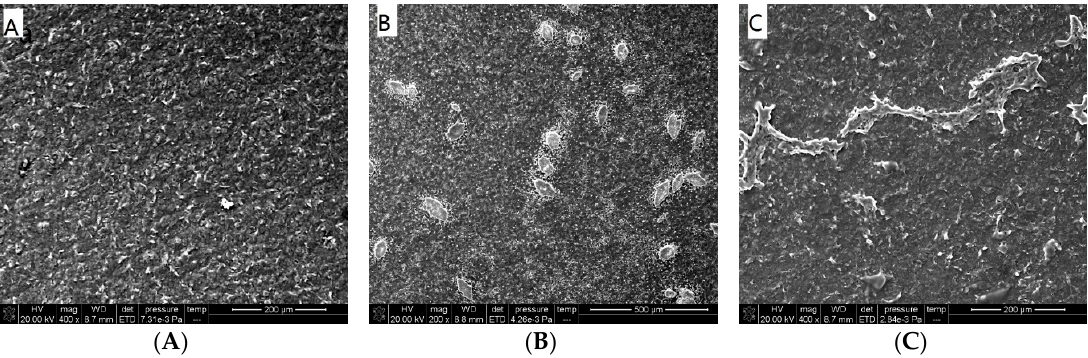
Figure 2. SEM images of different materials modified SPEs (( A ): naked SPE, ( B ): Fc(Cys) 2 /SPE; ( C ): Fc-ECG/SPE).